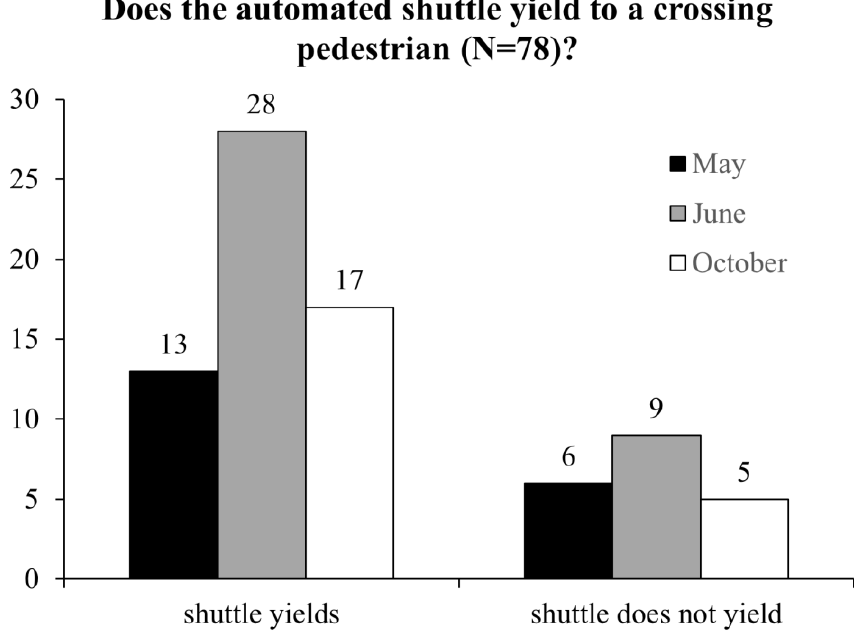
Figure 2 Interactions between automated shuttles and crossing pedestrians (Site